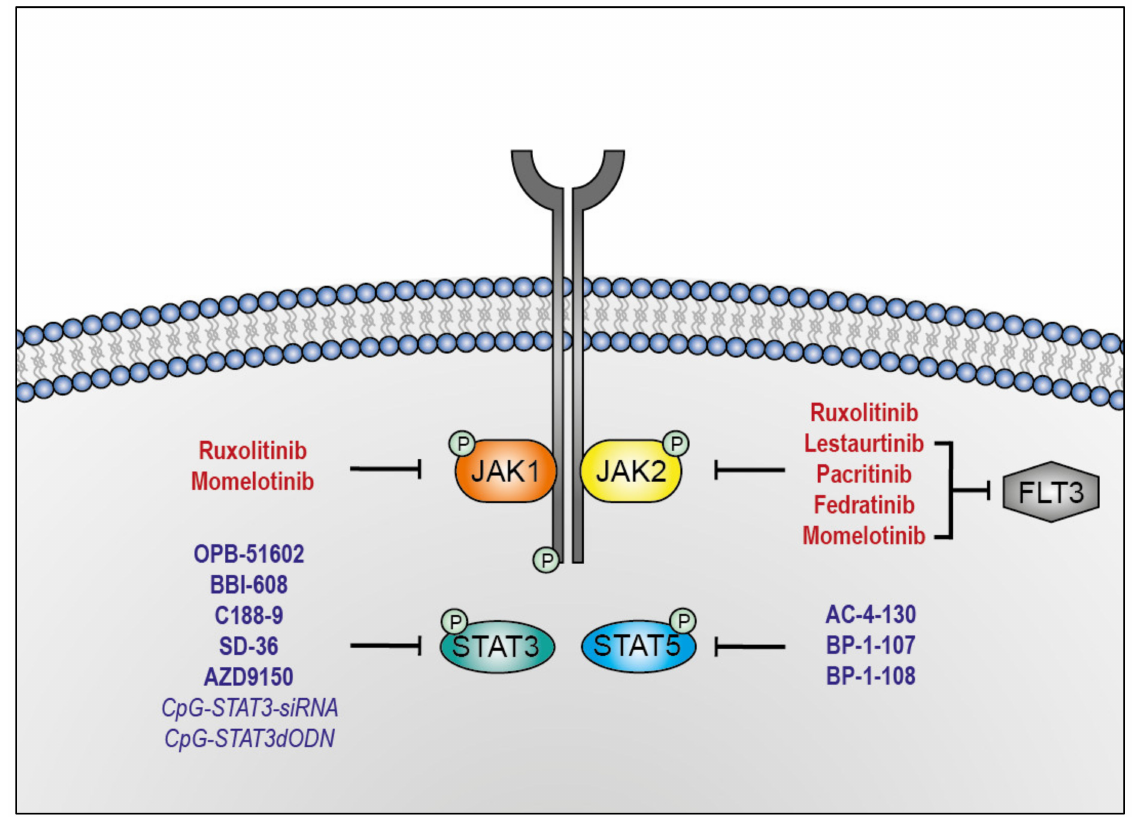
Figure 3. Targeting the JAK-STAT signaling pathway in AML. Representation of multiple JAK (red) and STAT (blue) inhibitors in clinical trials. Small interfering RNAs (siRNAs) and decoy oligodeoxynucleotide (dODN) are presented in